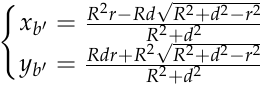
Figure 15. Reflective area diagram.